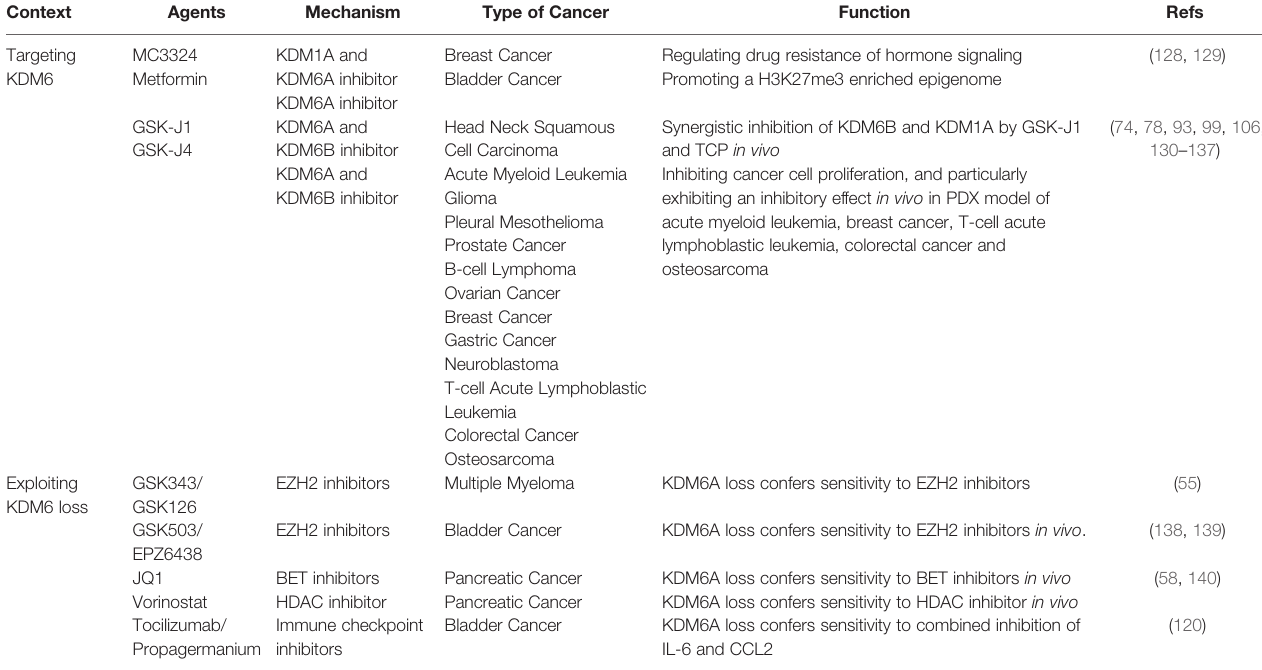
TABLE 2 | KDM6 in cancer